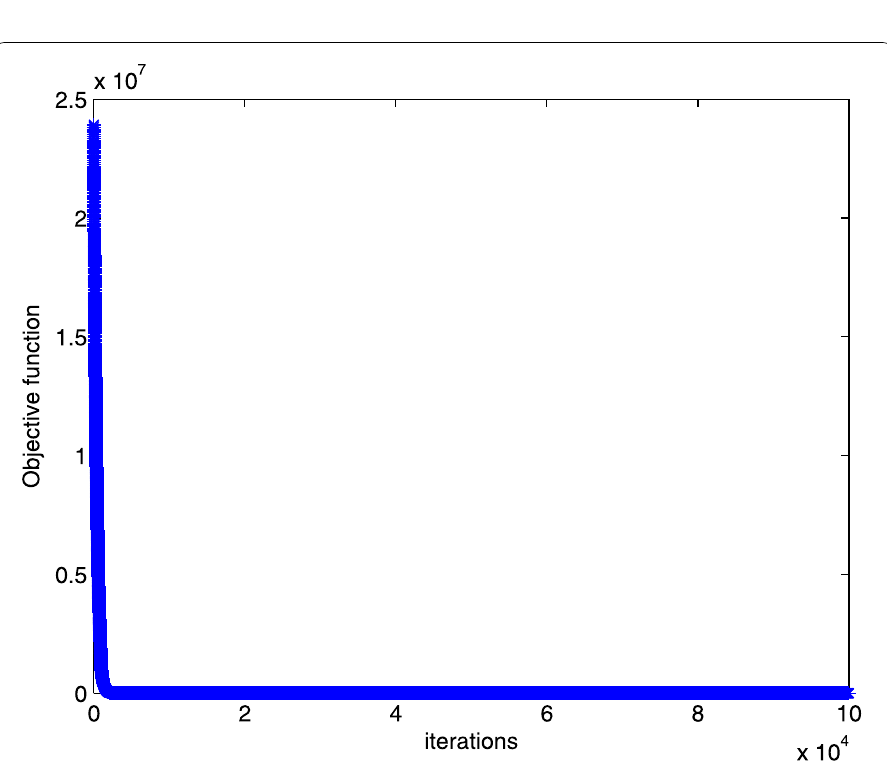
Figure 6 Numerical results for solving Example 3 with smoothing gradient